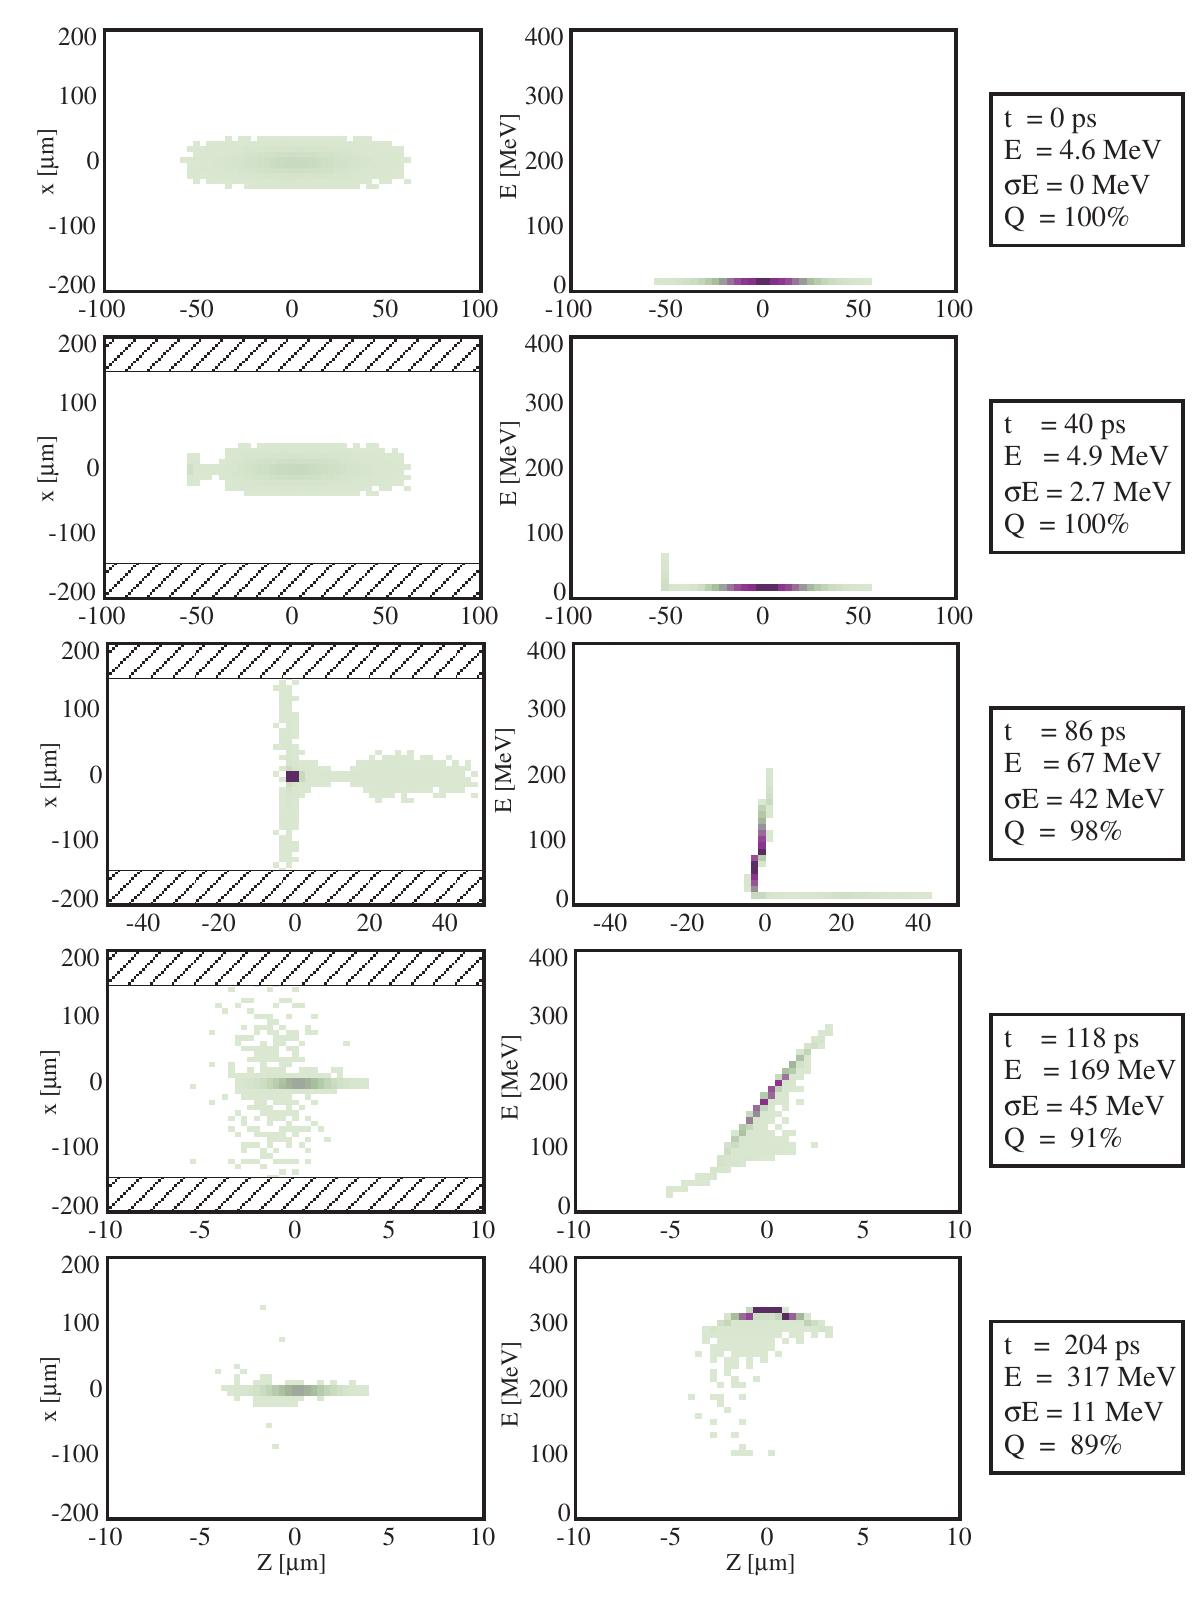
FIG. 8. (Color) Density plot of the time evolution for the radial profile (left) and energy (right) of an electron bunch injected 300 fs in front of a plasma wave from a laser pulse with a 0 ¼ 0 : 56 . For each snapshot, the time ( t ), energy ( E ), energy spread ( (cid:5)E ), and charge ( Q ) are given on the